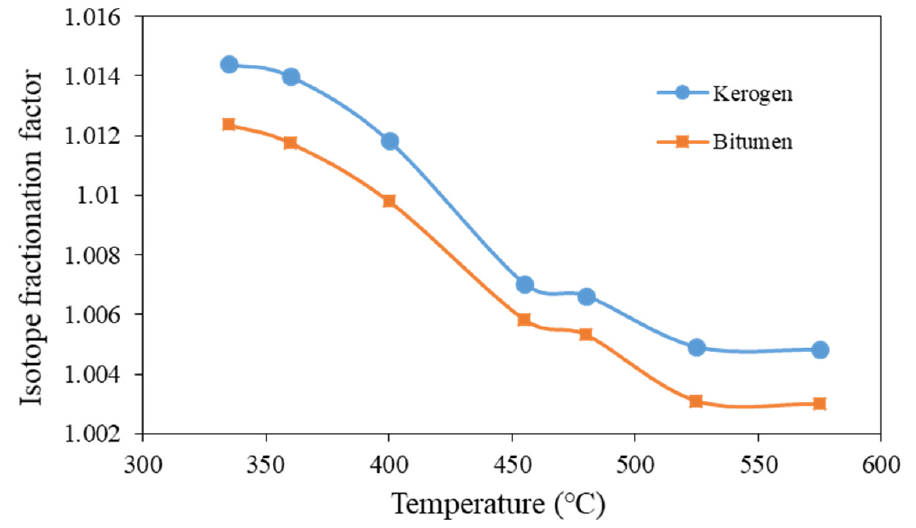
Figure 9. The isotope fractionation factors on the pyrolysis of kerogen and bitumen.